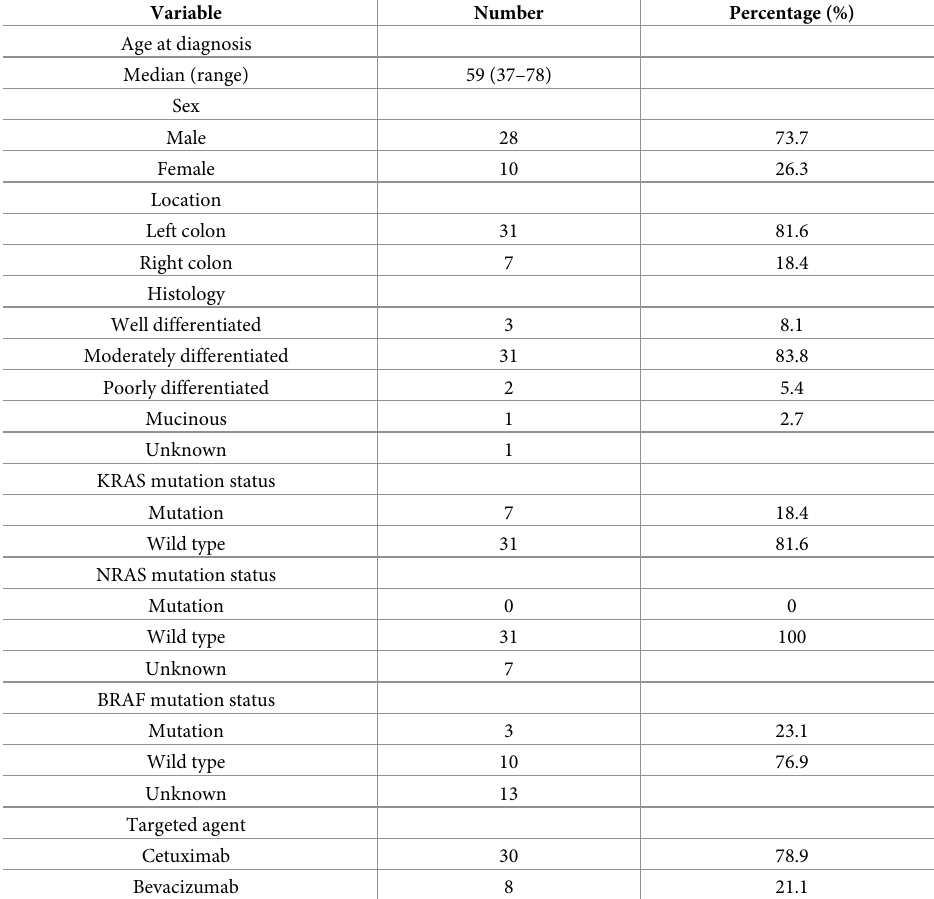
Table 2. Baseline characteristics of 38